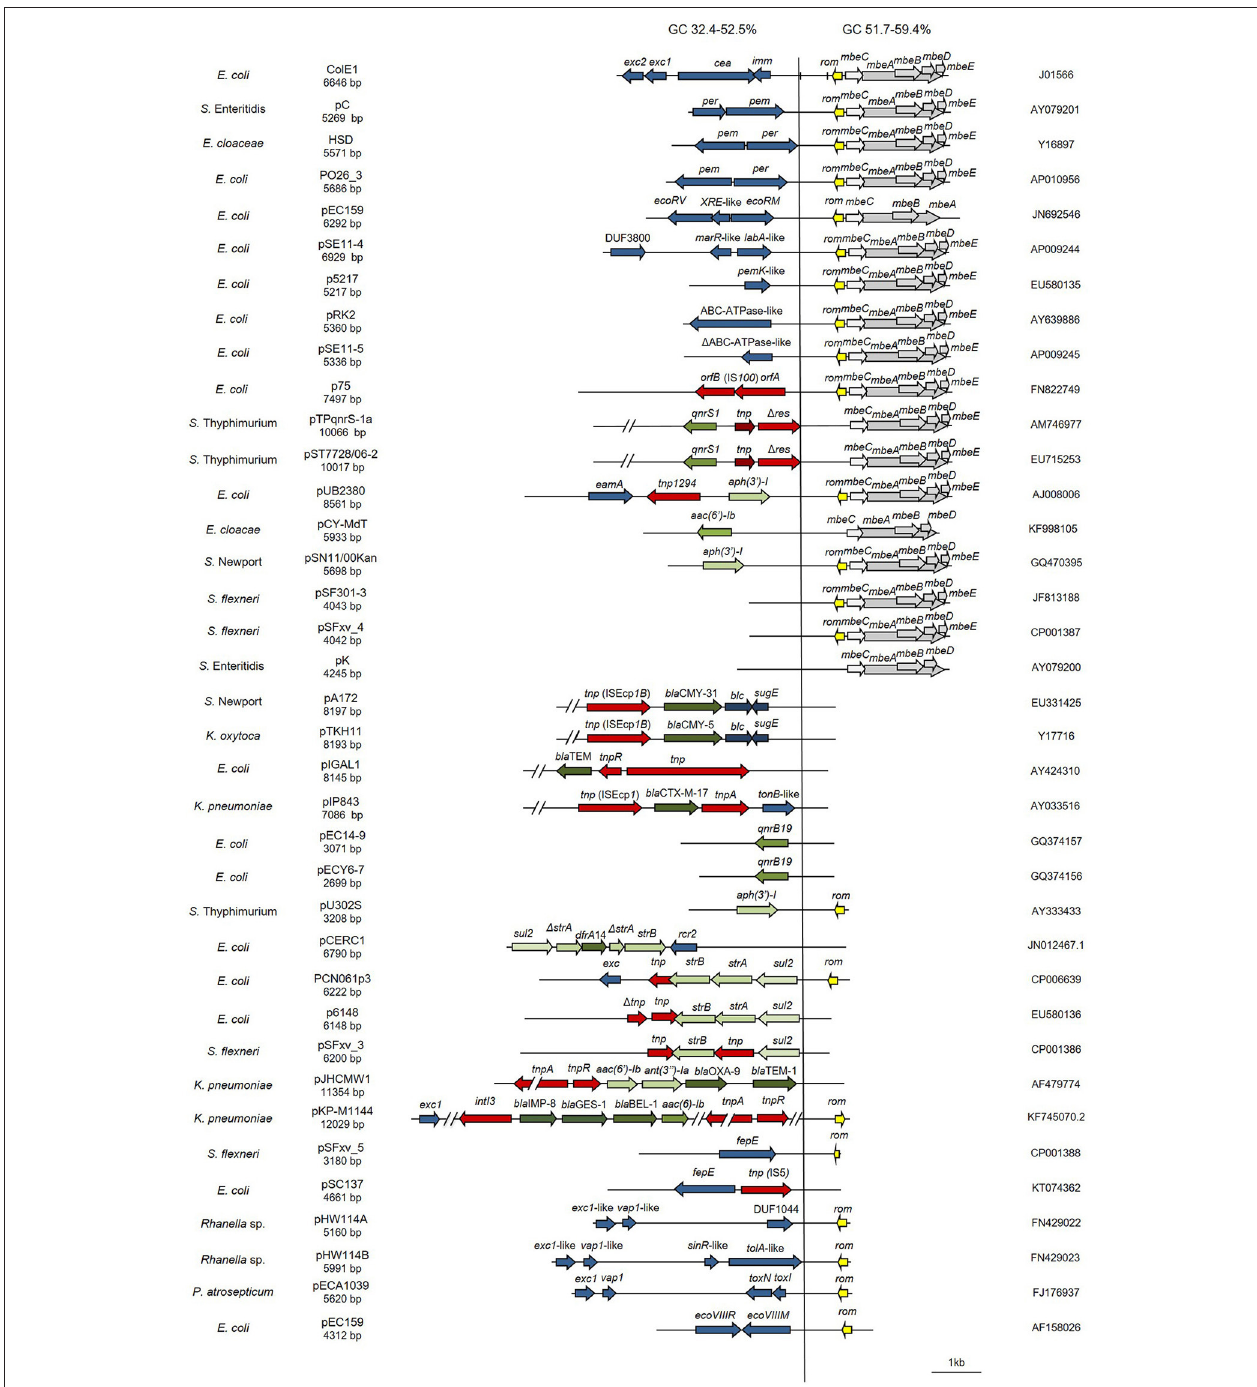
FIGURE 2 | Genetic structure of ColE1 plasmids from Enterobacteriaceae. Schematic diagram of the 37 ColE1 plasmids from the Enterobacteriaceae family studied in this work. The reading frames for genes are shown as arrows, with the direction of transcription indicated by the arrowhead. The names of the genes, or the names of the family of proteins they encode, are indicated. Antimicrobial drug resistance genes are shown in green and genes involved in genetic transposition or integration are shown in red. Genes encoding plasmid relaxases are shown in gray and the rom gene implicated in the regulation of plasmid replication is shown in yellow. The remaining ORFs are shown in blue. In ColE1, two vertical bars bracket the region containing the origin of replication ( oriV ) and the origin of transfer ( oriT ). The large vertical bar separates the conserved region of the plasmids, to the right, from the variable region of the plasmids, to the left. Percentage ranges of GC content of variable (Left) and conserved (Right) regions of the plasmids are indicated in the top of the figure. The species in which the plasmid has been described, and the name, size, and accession number of plasmids are also indicated.